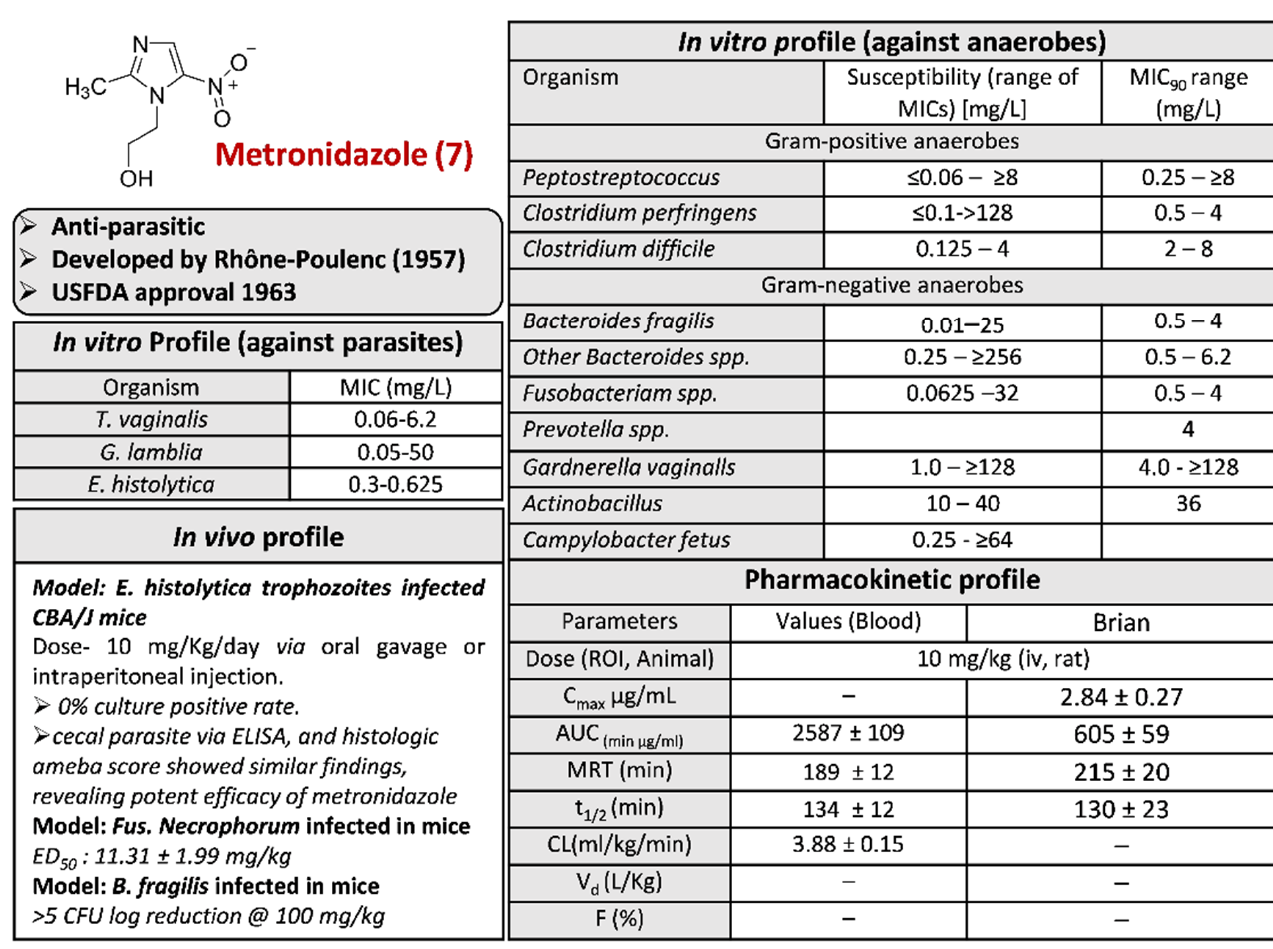
Figure 11. Activity profile of Metronidazole 7 [8,100–102].